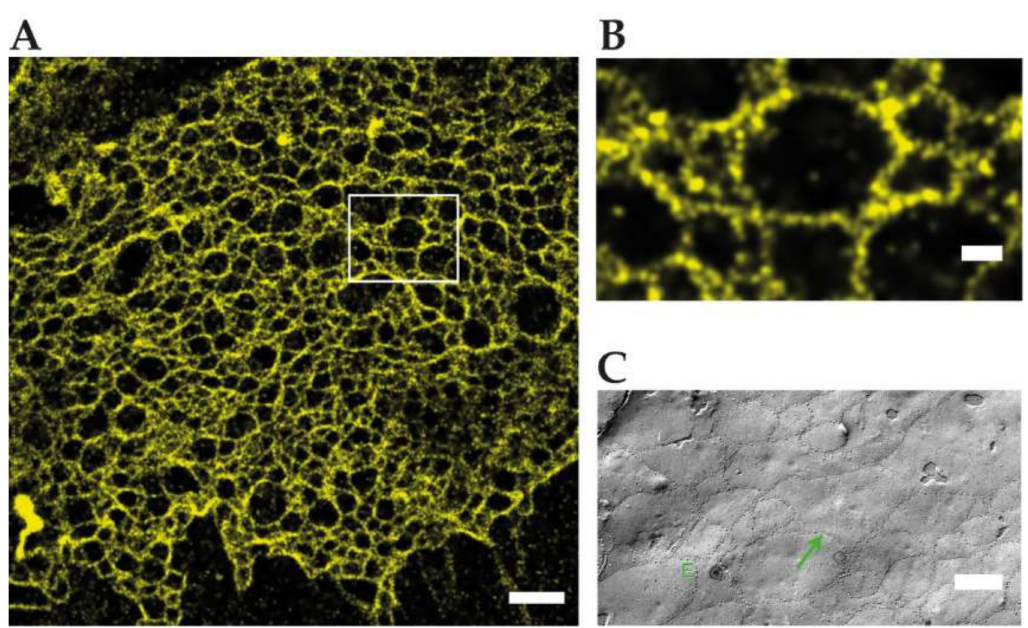
Figure 3. Reconstituted TJ networks formed by claudin3-YFP in HEK293 cells imaged by using SMLM (adapted from Kaufmann et al. 2012 [39]); ( A ) localization microscopy image of the region marked in the conventional wide-field fluorescence image with a mean e ff ective optical resolution 48 nm. Scale bar: 1 µ m; ( B ) magnification of claudin-3-YFP in HEK293 cells. Scale bar: 200 nm; ( C ) FFEM of